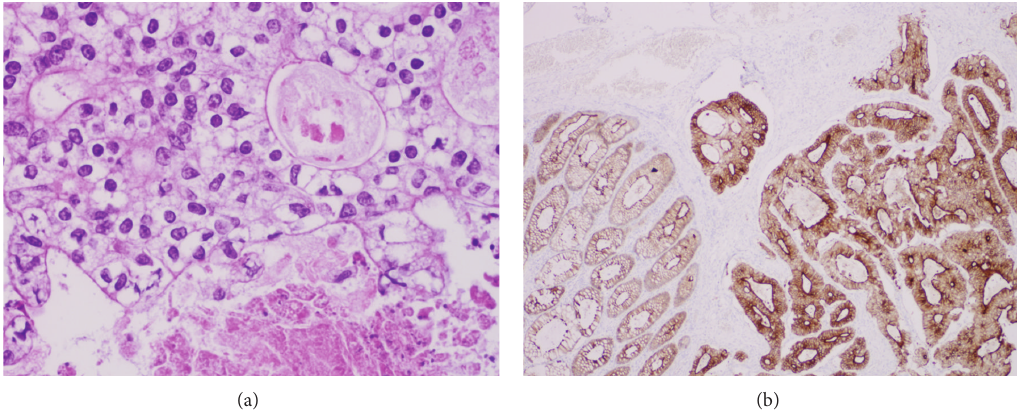
Figure 1: Histologic appearance of the clear cell adenocarcinoma of the colon. (a) H&E slide demonstrates rare variant of colonic adenocarcinoma with clear cell features. It shows gland-forming invasive tissue composed of columnar cells with unusually clear cytoplasm, prominentnucleolus,andcentralnecroticdebris(400x).(b)ImmunohistochemistryshowsastronglyCDX2positivestainingofthemalignant tissue (40x).